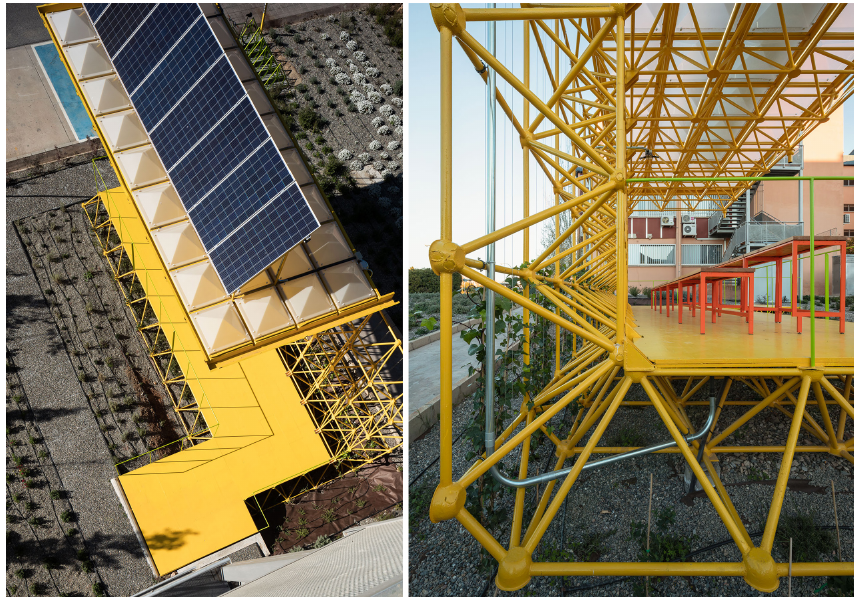
Figure 6. ( Left ): photovoltaic panels attached to the pavilion structure. ( Right ): the sensor connection ducts attached to the pavilion